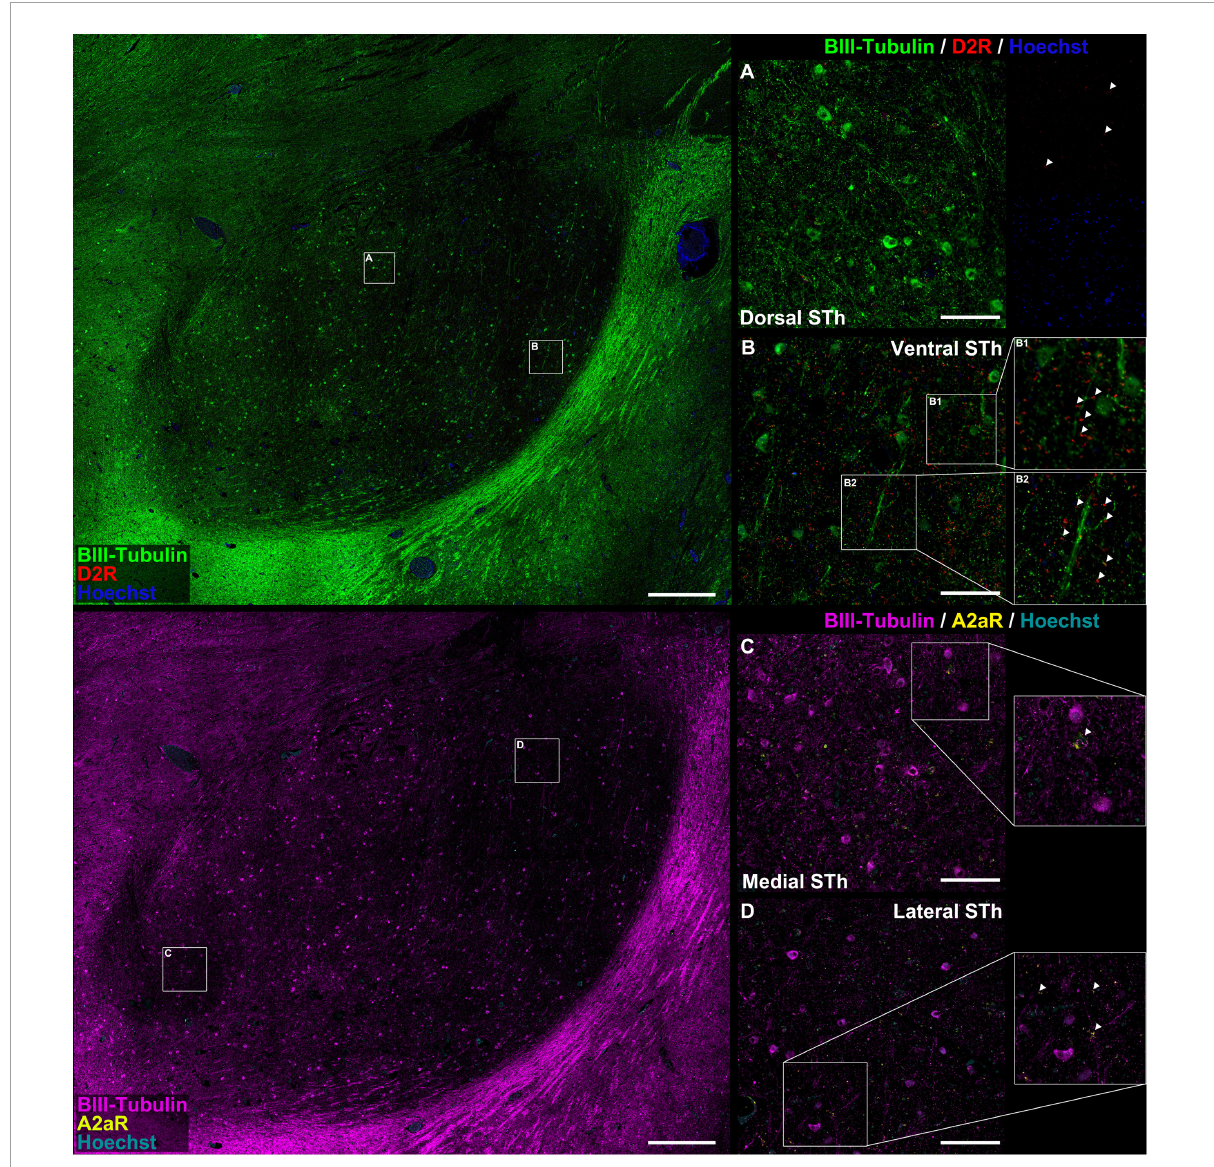
FIGURE2 Colocalization study between A 2 A R / D 2 R proteins and pan-neuronal marker β -III-tubulin. There appear to be significant differences in the distribution of D2 receptor immunofluorescent signal between the dorsal (A) and ventral (B) STh. In both instances, immunoreactivities mostly colocalized with β -III-tubulin neuritic structures at the level of dendritic spines [magnification in (B) ]. In some occasions, D 2 R did not colocalize with β -III-tubulin, suggesting for the expression of the receptor also in non-neuronal cells. A 2 A R can be found as dot-like immunoreactivities colocalizing with β -III-tubulin positive neurites or as rare somatic cytoplasmic reactivities (C,D) , even though non- β -III-tubulin colocalizing reactivities were also